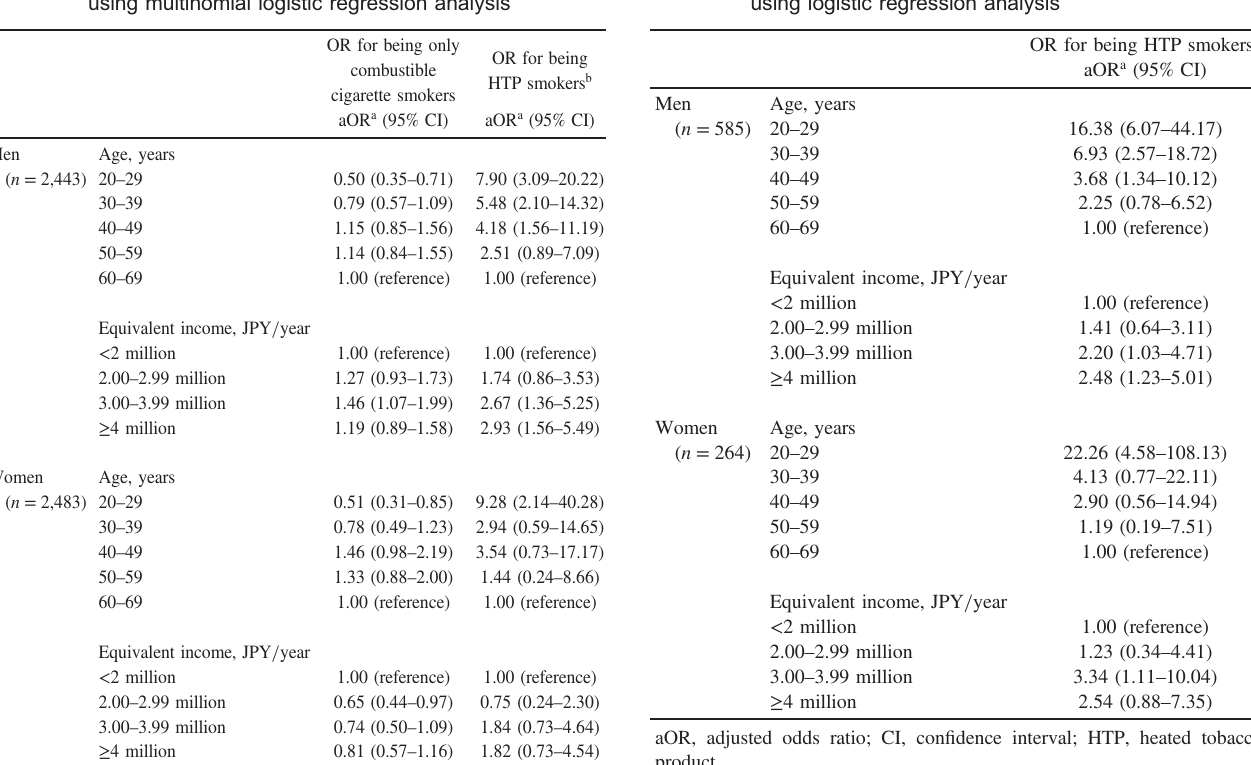
Table 3. Odds ratios of age and equivalent income for